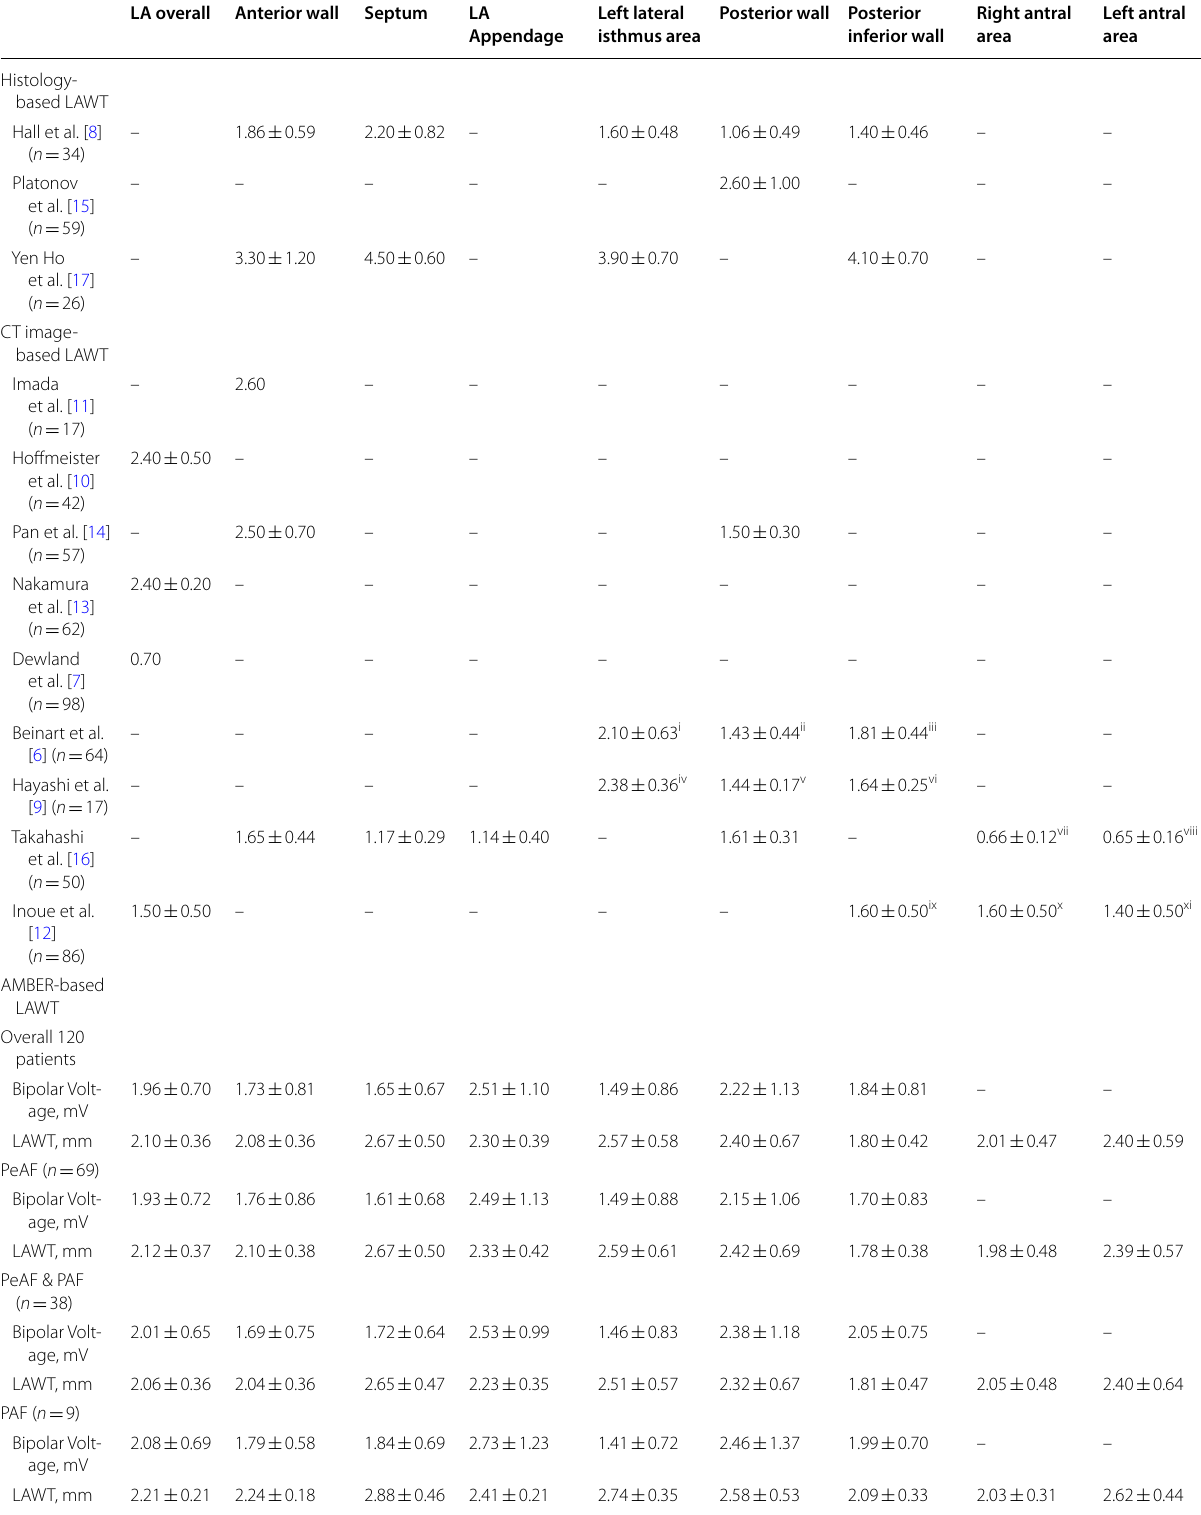
Table 2 Comparison of regional left atrial wall thickness and 12 previously reported studies LA overall Anterior wall Septum LA